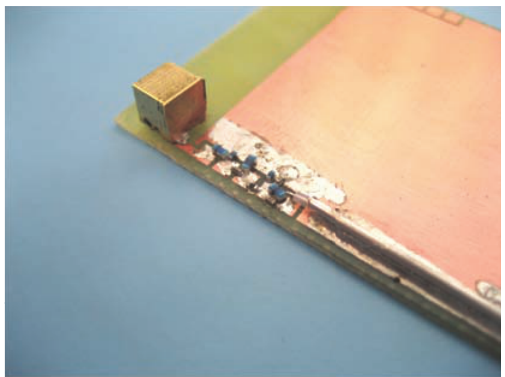
F 32: Single-band prototype including the reactance cancella- tion inductor and the broadband matching network.